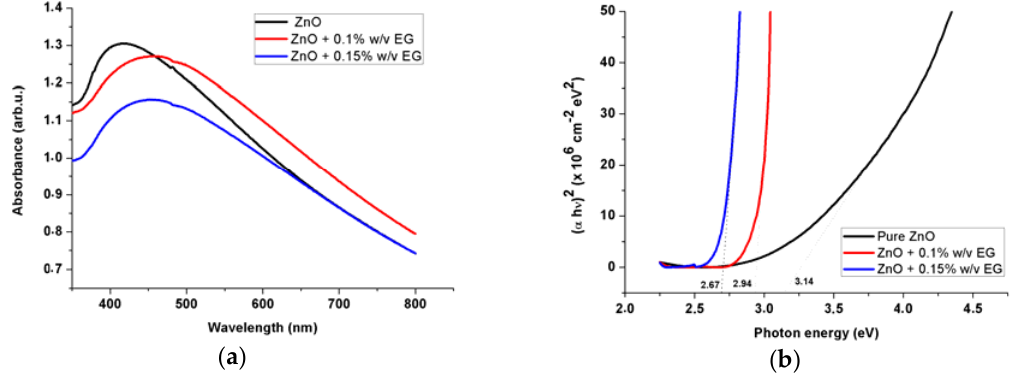
Figure 5. UV–Vis absorption spectra, shows the plot of ( α E) 2 versus photon energy for the ZNRs grown with different amount of